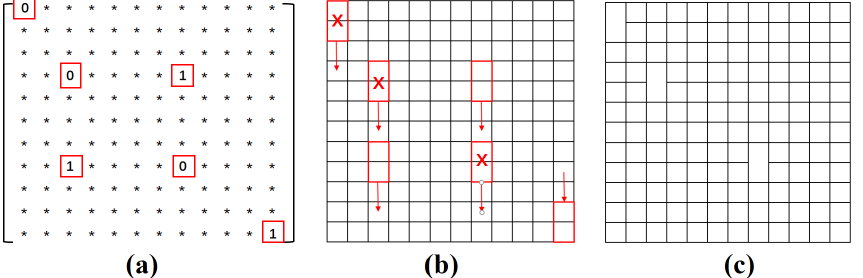
Figure 9. Demonstration of the second step of transforming the grid: ( a ) the vertical pair label matrix; (b) scan and transform the grid; ( c ) the result of transformation.